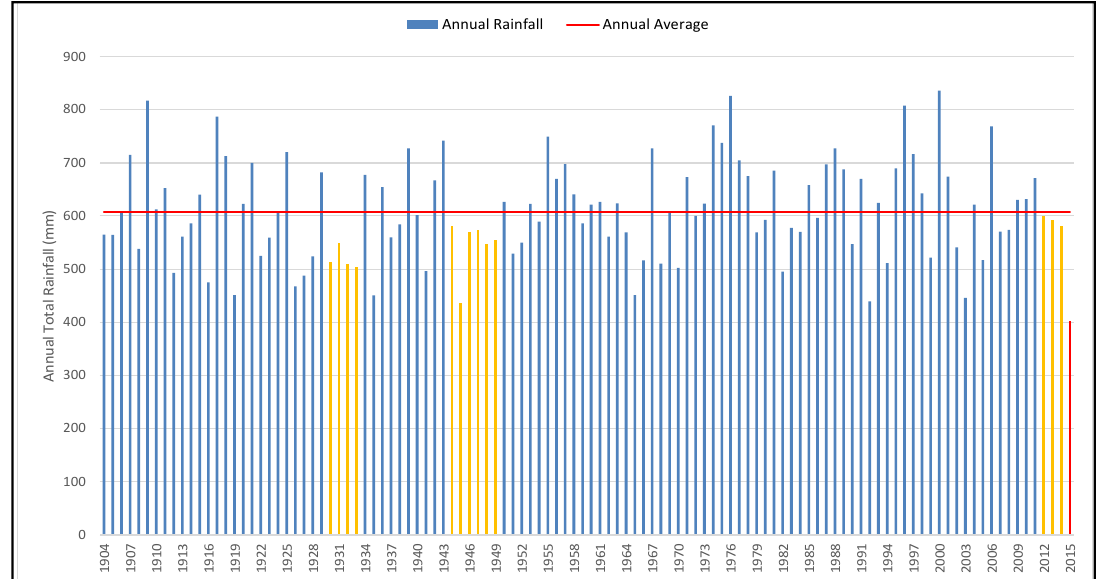
Figure 1. South Africa’s annual total rainfall from 1904 to 2015 [8].